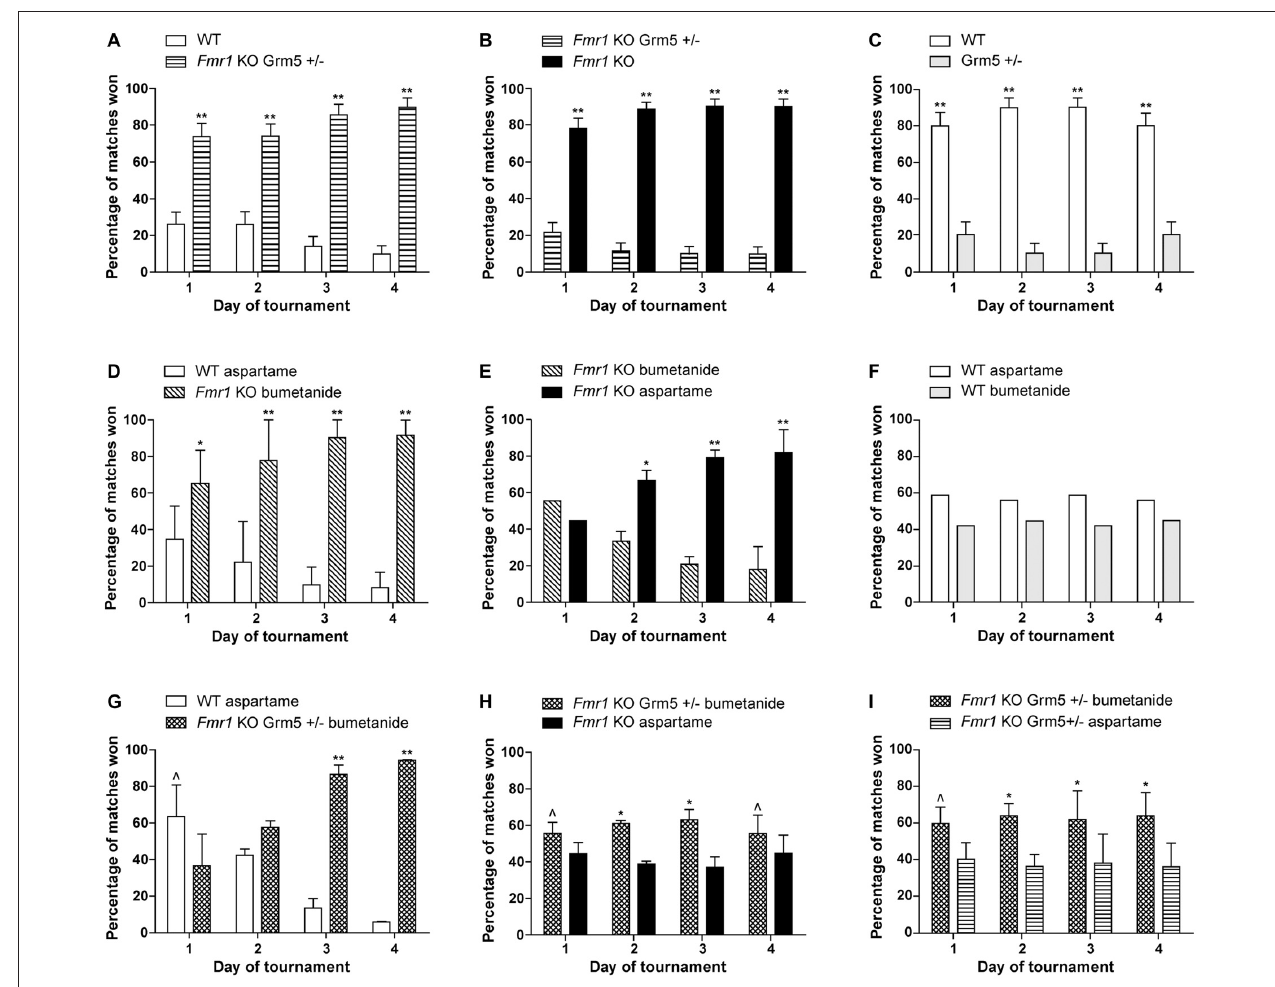
FIGURE 1 | Reduction of metabotropic glutamate receptor 5 (mGluR5) or enhancing γ -aminobutyric acid (GABA) separately, partially improves the Fragile X syndrome (FXS) phenotype, while a combination therapy slightly worsens this effect. Results are indicated as percentage of matches won by Fmr1 KO mice and wild-type (WT) littermates. To explain what is meant by a partial correction in the tube test: a full correction would implicate a 50%–50% result of the matches between WT mice and treated Fmr1 KO mice. In that case, both groups show a similar social behavior phenotype. When a partial correction is observed, there is a clear dominant phenotype of untreated Fmr1 KO mice compared to treated Fmr1 KO mice, while treated Fmr1 KO mice do not show a correction in matches against WT mice. (A–C) Previously published results from de Esch et al. (2015) presenting that genetic reduction of mGluR5 partially corrects the automated tube test (ATT) phenotype in Fmr1 KO mice. (A) Fmr1 KO mice who are Grm5 +/ − continue to show a strong phenotype compared to their WT littermates ( p < 0.001, n = 12 per group). (B) Strong reduction of ATT phenotype with mGluR5 reduction: Fmr1 KO win most matches against Fmr1 KO mice who are Grm5 +/ − ( p < 0.001, n = 10 per group). (C) Genetic reduction of mGluR5 induces an inverse phenotype in the WT animals in the ATT ( p < 0.001, n = 6 per group). (D–F) Chronic treatment with bumetanide partially correct the ATT phenotype in Fmr1 KO mice. (D) Fmr1 KO mice treated with bumetanide continue to show a strong phenotype compared to their WT littermates receiving aspartame drinking water ( p < 0.01 on day 1 and p < 0.001 on day 2–4, n = 12 per group). (E) Strong reduction of ATT phenotype after bumetanide treatment comparing treated and untreated Fmr1 KO mice: Fmr1 KO receiving aspartame water win most matches against Fmr1 KO treated with bumetanide after day 1 ( p < 0.01 on day 2, p < 0.001 on day 3 and 4, n = 12 per group). (F) WT mice receiving bumetanide in their drinking water and WT mice receiving aspartame drinking water win equal amounts of matches ( p > 0.1 for all days, n = 6 per group). (G–I) Combination of genetic mGluR5 reduction